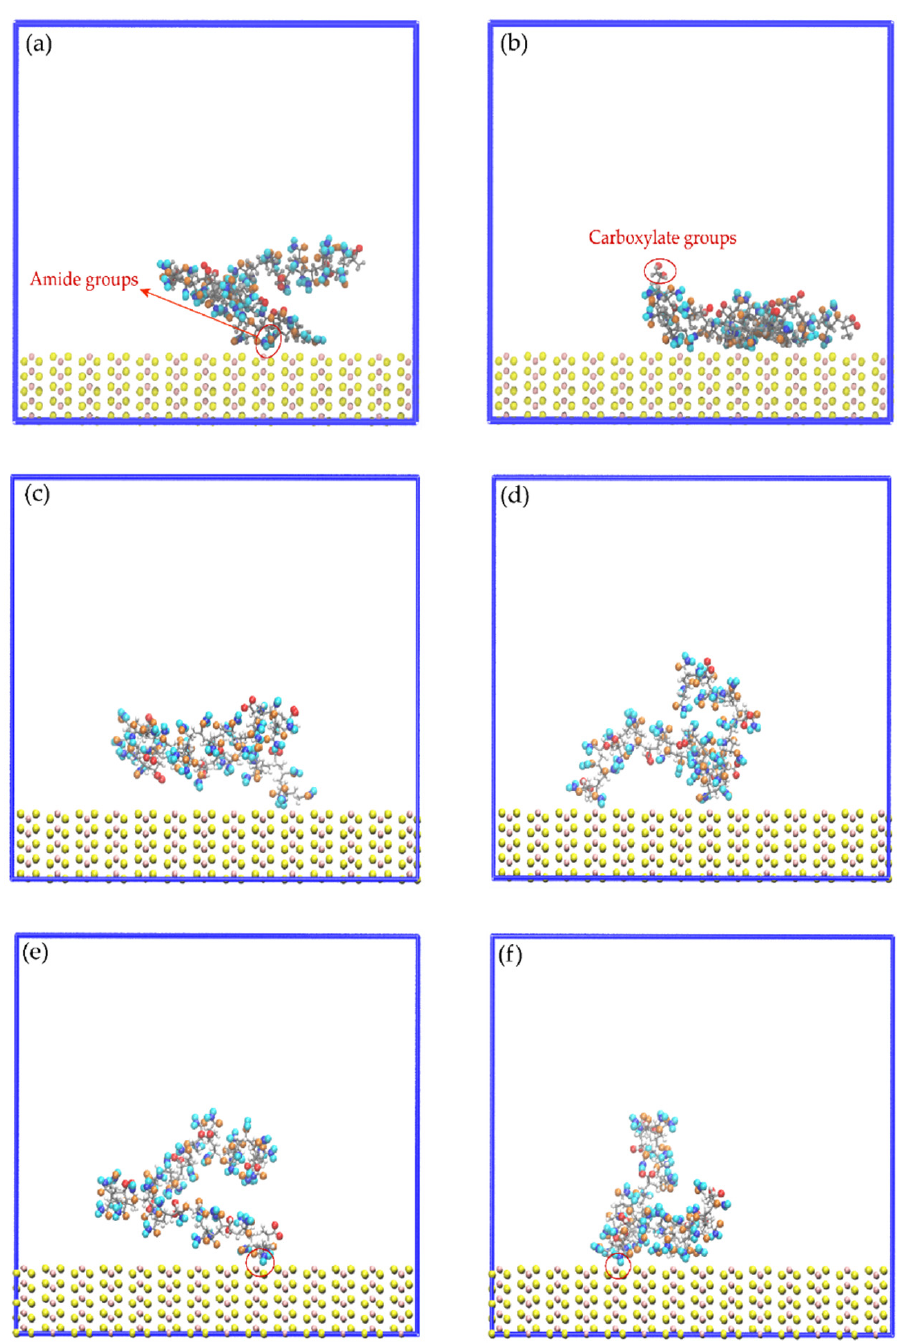
Figure 11. Snapshots of the initial configuration for simulation of two molecules of HPAM over the edge of MoS 2 : ( a ) side view, ( b ) top view.